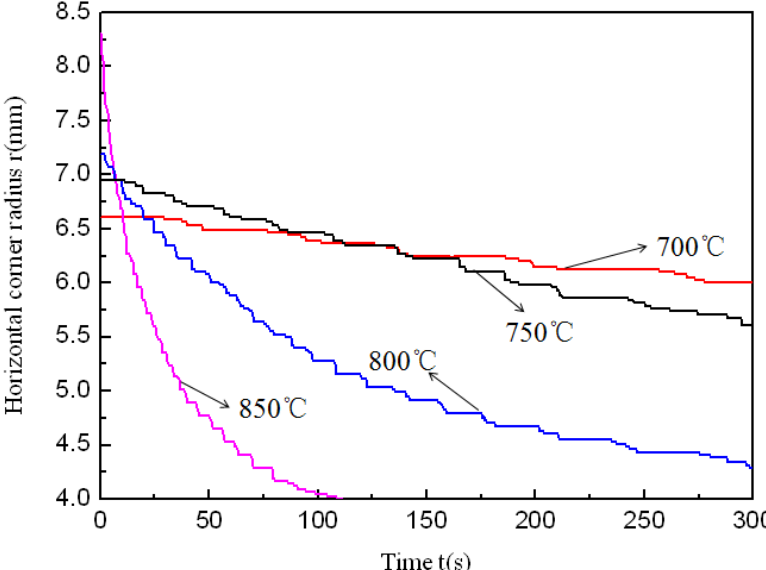
Figure 8. Corner filling process at various temperatures and at the same pressure level of 30